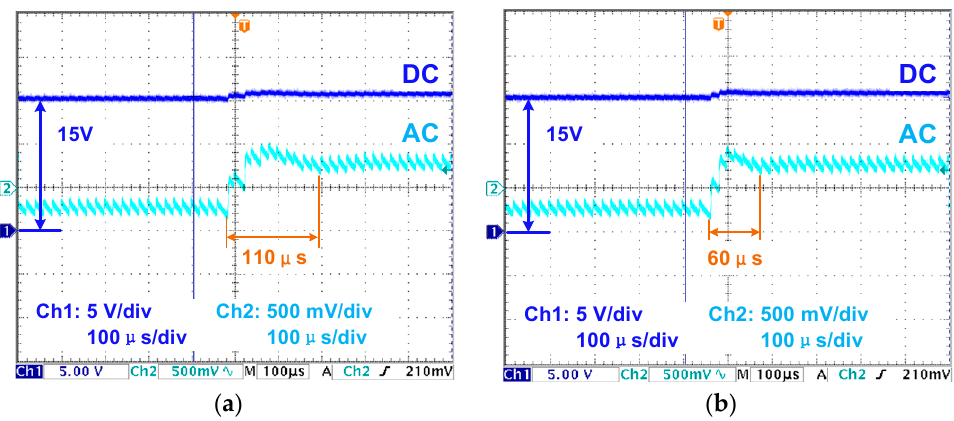
( b ) Figure 17. Output voltages when R steps from 50 Ω to25 Ω . ( a ) SCB controller, ( b ) OSCB controller.